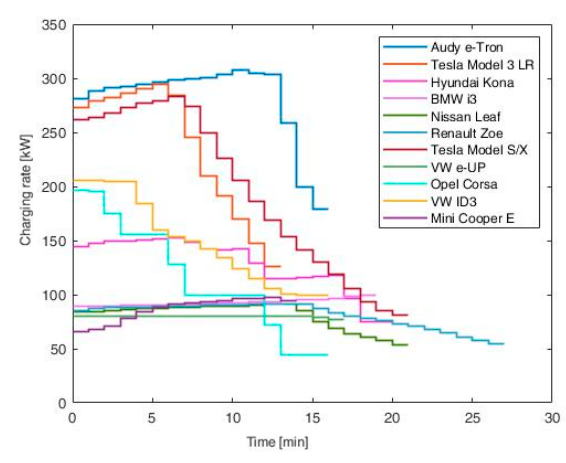
Figure 14. Future charging profiles.